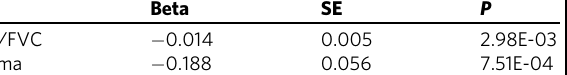
Table 1 Observational associations of expiratory volume in 1 s/forced vital capacity (FEV1/FVC) ratio Z-score and asthma with comparative body size at 10 years of